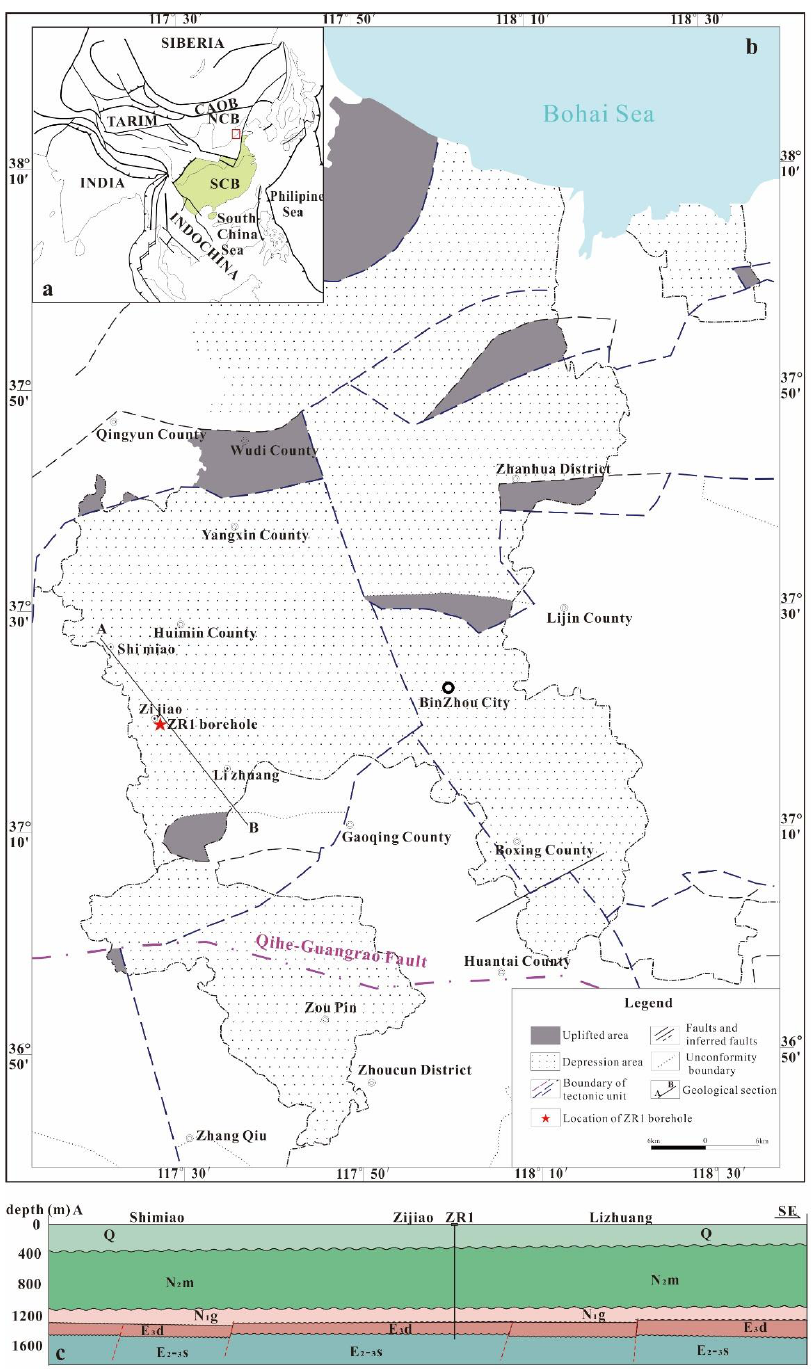
Figure 1. Conceptual geological map of Binzhou, China. ( a ) Tectonic location of the Binzhou geothermal field [20]; ( b ) geological map of Binzhou geothermal field. The red star donates the location of the ZR1 borehole used in this study; ( c ) geological section of Shimiao-Lizhuang. The location of the section can be found in ( b ). Abbreviations: CAOB—Central Asian Orogenic Belt; NCB—North China Block; SCB—South China Block;